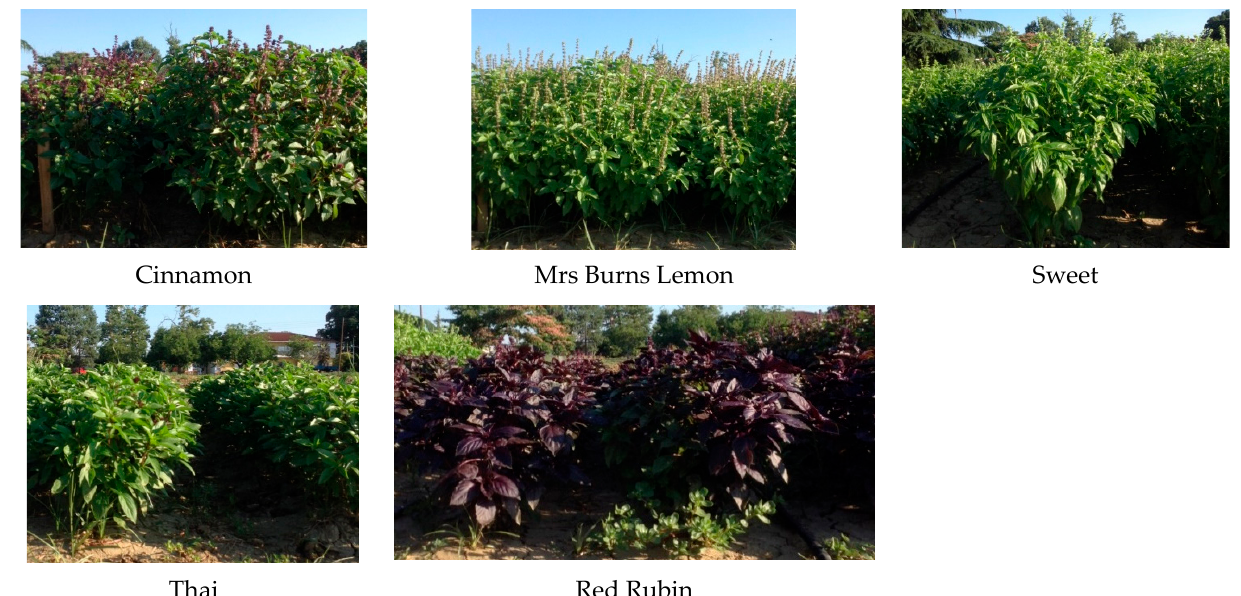
Figure 11. Photographs of the five cultivars that were used in this